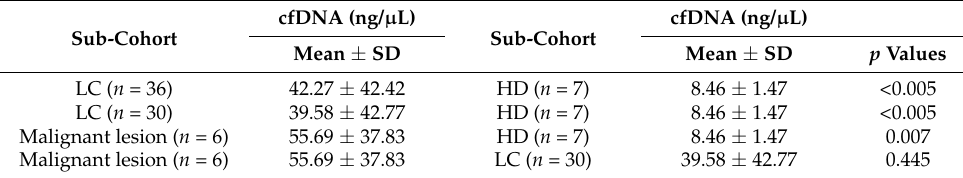
Table 6. Comparison of cfDNA amounts between sub-cohorts with liver cirrhosis (LC), malignant lesions and healthy donors (HD). A significant difference between cfDNA level in LC patients and HD ( p < 0.005) and between cfDNA level in patients with malignant lesions (including HGDN and early HCC) and HD ( p < 0.005) was found. No significant difference ( p = 0.467) was found when the level of cfDNA from the patients with HGDN, early HCC or HCC was compared to the level of cfDNA in cirrhotic patients.